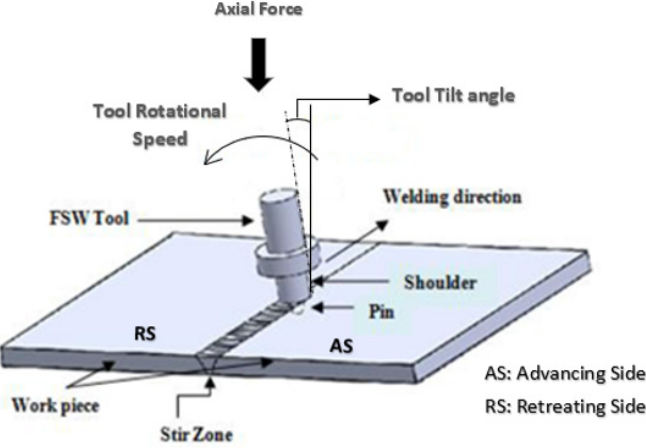
Figure 1. Schematic diagram of FSW [4].